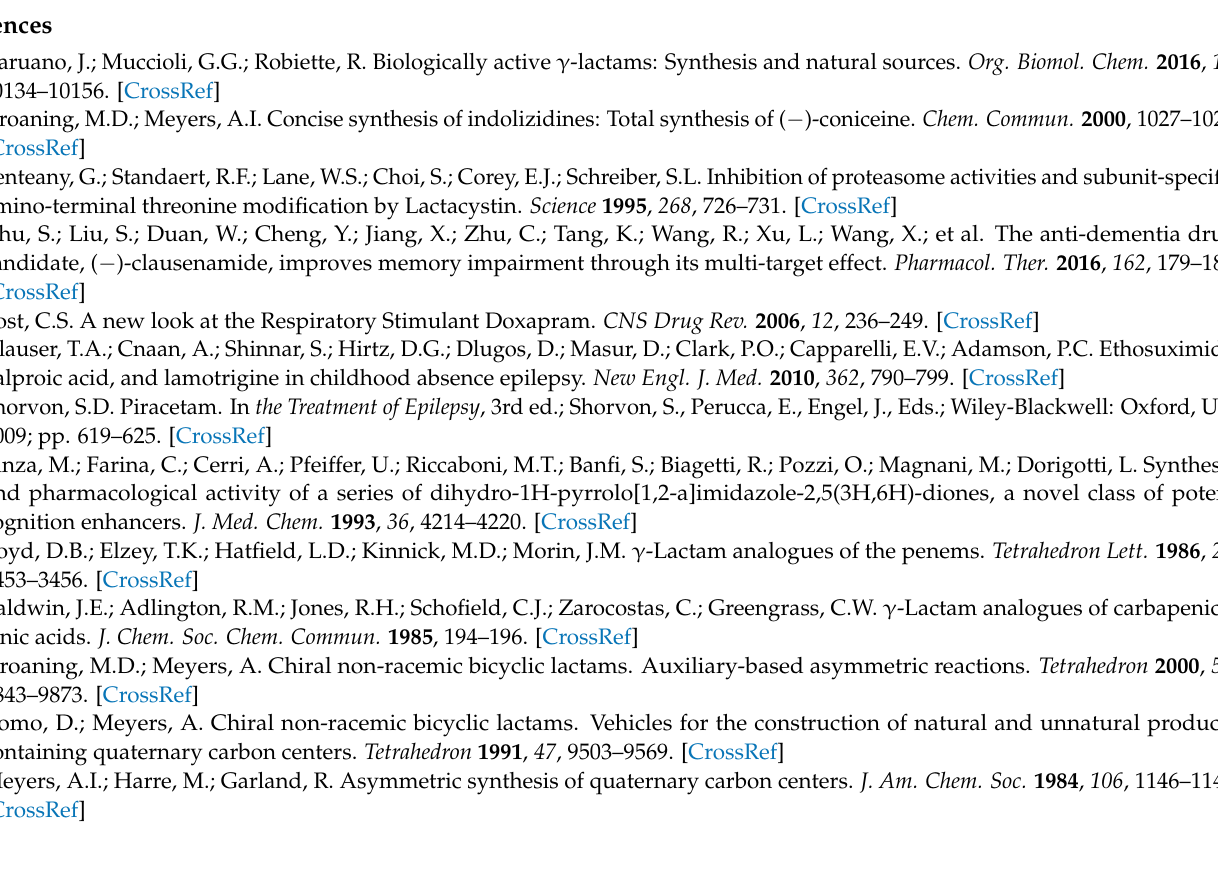
Figure S52: 13 C NMR spectrum of a mixture of 9 : 9’ in the ratio ≈ 1:1; Figure S53: 19 F NMR spectrum of mixture of 9 : 9’ in the ratio ≈ 1:1; Figure S54: 1 H NMR spectrum of mixture of 10 : 10’ in the ratio 56:44; Figure S55: 13 C NMR spectrum of mixture of 10 : 10’ in the ratio 56:44; Figure S56: 19 F NMR spectrum of mixture of 10 : 10’ in the ratio 56:44; Figure S57: 1 H NMR spectrum of 11a ; Figure S58: 13 C NMR spectrum of 11a ; Figure S59: 19 F NMR spectrum of 11a ; Figure S60: 1 H NMR spectrum of 11b ; Figure S61: 13 C NMR spectrum of 11b ; Figure S62: 19 F NMR spectrum of 11b ; Figure S63: 1 H NMR spectrum of mixture of 11b : 11b’ in the ratio 72:28; Figure S64: 13 C NMR spectrum of mixture of 11 : 11’ in the ratio 72:28; Figure S65: 19 F NMR spectrum of mixture of 11 : 11’ in the ratio